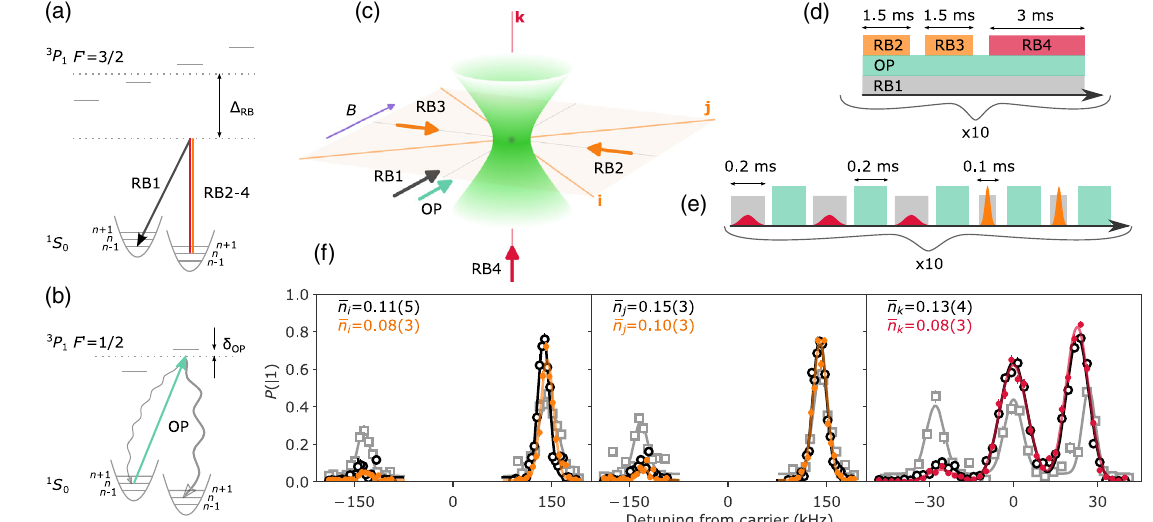
FIG. 5. Raman-sideband cooling to the 3D motional ground state. (a) Level diagram for the two-photon transitions employed in 1 = 2 ; n i state absorbs a photon from the π -polarized beam (RB2-4) and emits into the σ þ -polarized cooling. An atom in the j m F ¼ þ beam (RB1). With the relative frequency difference of the two beams tuned a trap frequency away from the carrier, the atom can change its motional state to n − 1 (red sideband) or n þ 1 (blue sideband), depending on the sign of the difference. The Raman detuning from = 2 π ¼ − 183 MHz. (b) Optical pumping (OP) scheme for energy dissipation during cooling. In the the intermediate excited state is Δ RB Lamb-Dicke regime, the scattering from the pumping beam is unlikely to alter the atom ’ s motional state but pumps into the opposite spin = 2 π ¼ − 2 MHz red detuned from resonance. (c) Raman state, where the cooling can begin anew. We operate with optical pumping δ OP beams (RB1-4), optical pumping, and magnetic field ( B ) geometry. RB1 paired with RB2-4 addresses motional states along the i , j , and k axes, respectively. (d) Continuous sideband cooling. RB1 and OP beams are continuously illuminating the atoms, while the remaining RB2-4 are turned on and off iteratively. (e) Pulsed sideband cooling. A pulse of RB1 and one of RB2-4 drives an approximate π rotation on the relevant sideband, followed by a step of optical pumping. (f) Sideband thermometry along the i , j , and k axes. Spectra are acquired before sideband cooling (gray squares), after 3D optimized cooling (black open circles), and after cooling optimized for radial (orange points) and axial (red points) directions. Each panel shows the red sideband (left) and blue sideband (right) for the corresponding cooling direction. Axial spectra additionally include the carrier (middle). Mean phonon occupation number ( ¯ n ) after sideband cooling is quoted for each axis. The error bars correspond to standard deviations of the binomial distributions given by the measured